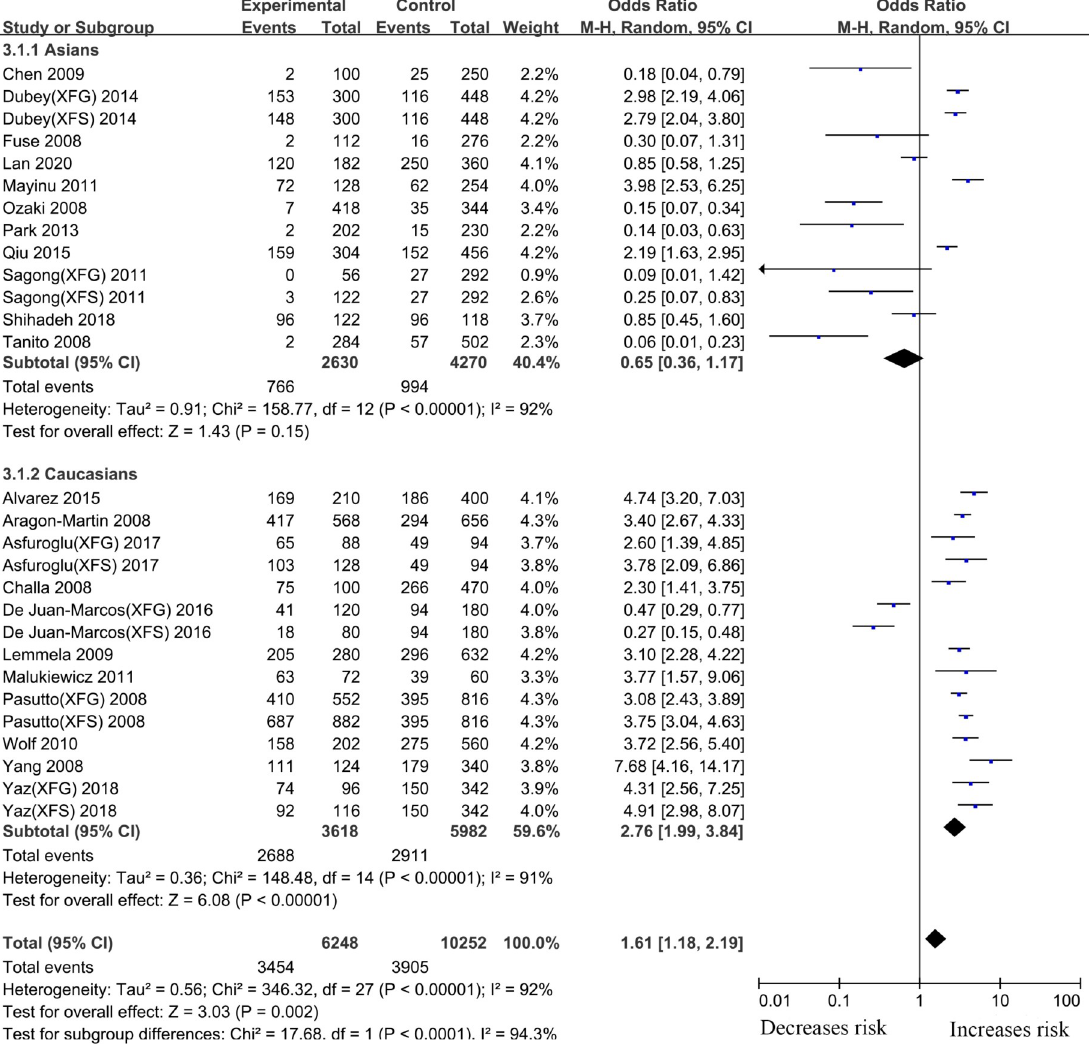
Fig 5. Meta-analysis for the association between exfoliation syndrome/exfoliation glaucoma risks and LOXL1 gene polymorphism rs2165241 (G vs. A): Subgroup analysis by ethnicity (squares depict individual studies and diamonds depict summary effect size estimates (Odds Ratio,